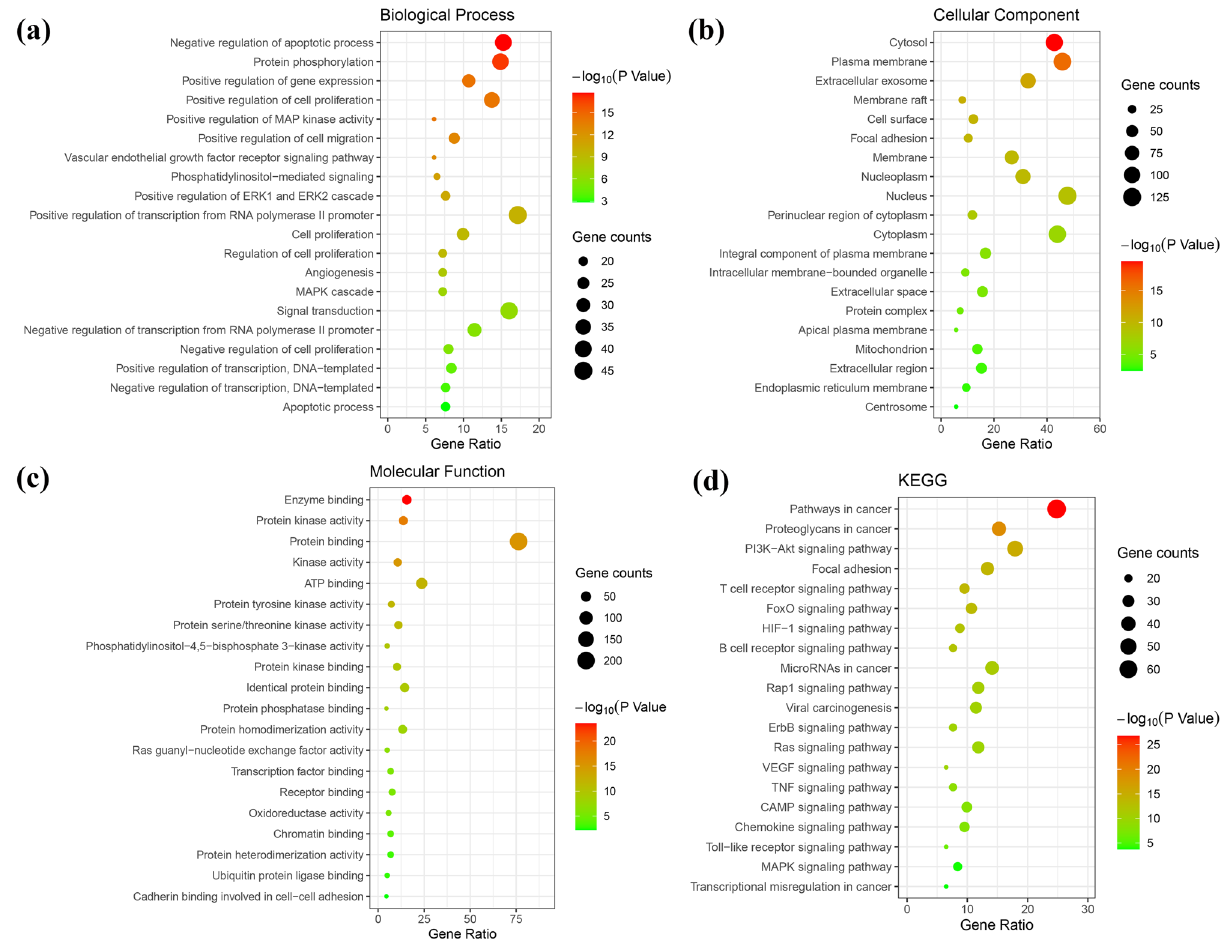
Figure 5. Bubble map of GO and KEGG pathway analyses. ( a ) Biological processes (BP) of GO terms. ( b ) Cellular components (CC) of GO terms. ( c ) Molecular functions (MF) of GO terms. ( d ) KEGG pathway analysis. Bubble size represents the number of enriched genes, and bubble colour difference represents the significance of target gene